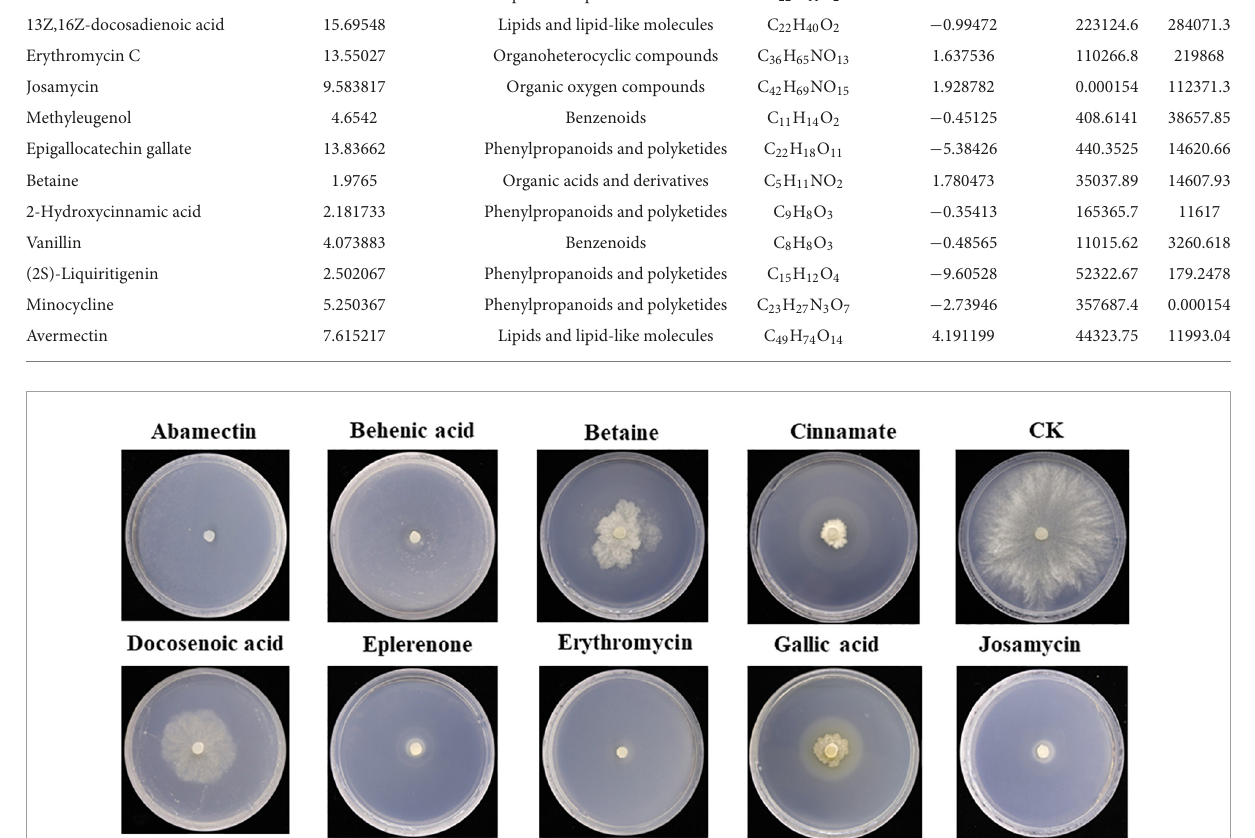
in different processes was determined ( Figure 8 ). Biological